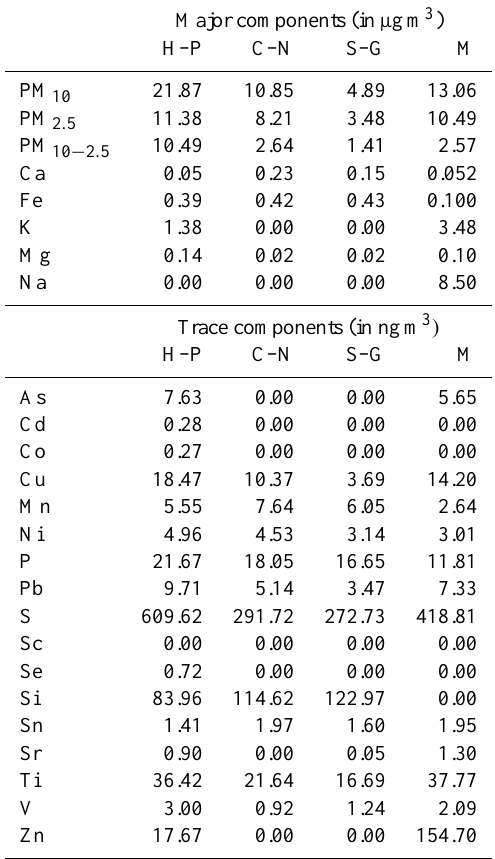
Table 5. Daily levels of PM 10 , PM 2 . 5 , PM 10 − 2 . 5 and ma- jor (µgm − 3 ) and trace components (in ngm − 3 ) for PM 10 in the Huelva–Portugal (H–P), continental–north (C–N), Seville– Guadalquivir (S–G) and marine (M)